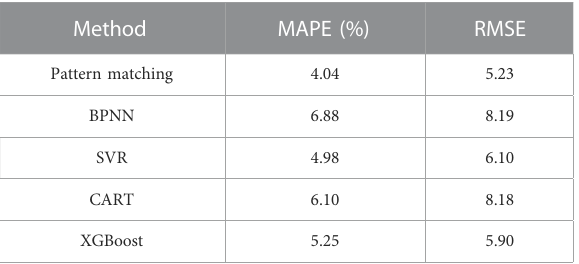
TABLE 2 Load forecasting results of different methods.